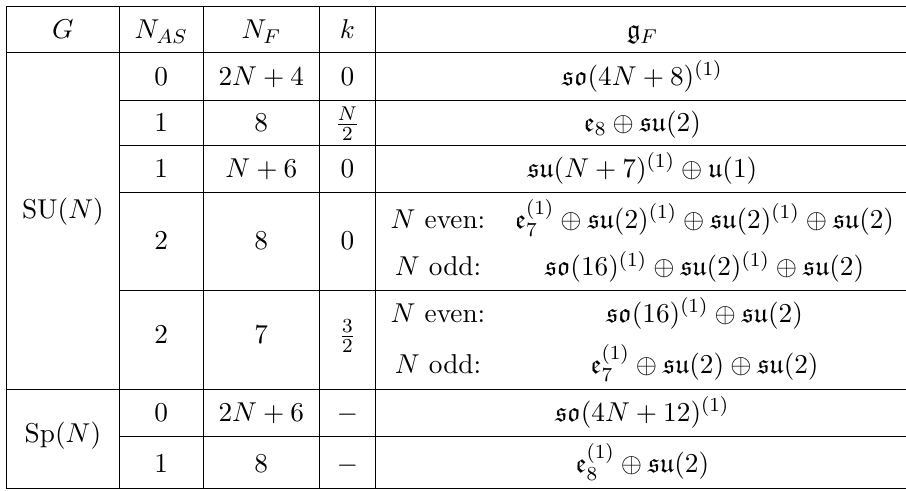
Table 4 . List of marginal 5d gauge theories, which whose descendant trees will considered in this paper. The gauge group is G and N denotes the number of matter hypermultiplets in the R representation R . For SU( N ) we list the CS-levels k . g is the flavor symmetry algebra of the F marginal theory. Here, the superscript (1) denotes the affine